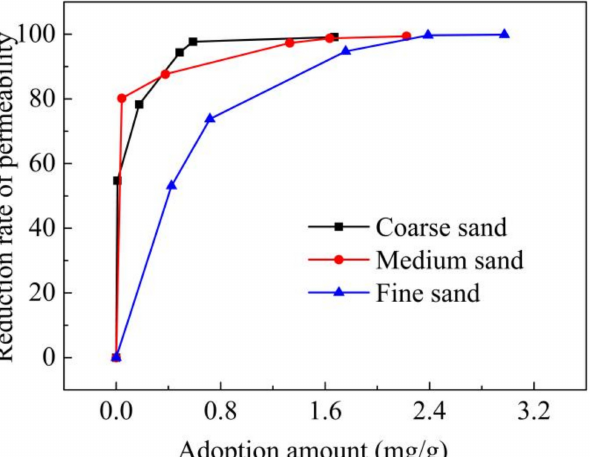
Figure 6. Quantitative relationship between permeability reduction and adsorption